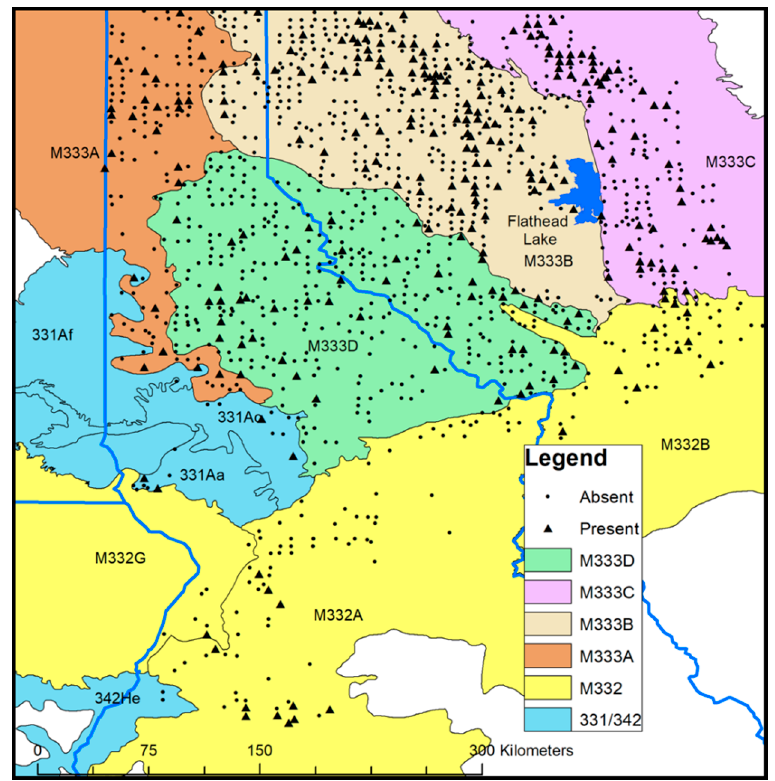
Figure 1. Approximate locations of 1286 forest plots with a western larch component used in seedling presence/absence models within the Montana and Idaho portion of the northern Rocky Mountains. Plots with seedlings present are displayed with solid triangles, while the plots with seedlings absent are displayed with circles. Shaded areas represent six ecoregion province/section designations defined in McNabb et al. [53].